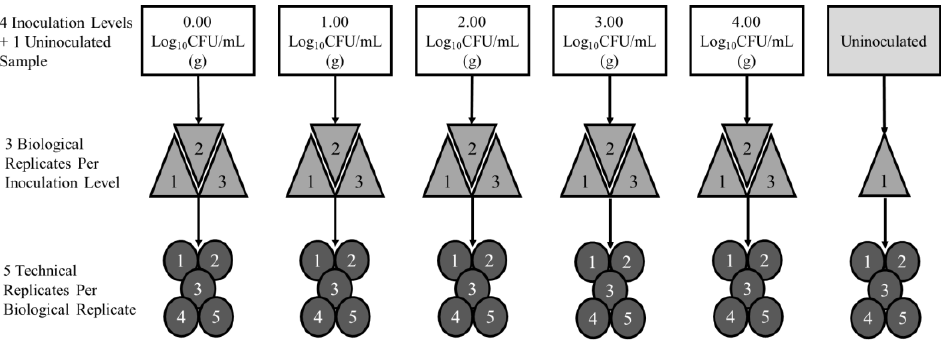
Figure 1. Curve Development Experimental Design for Boot Swabs, Processing Rinsates, Ground Chicken, and Ground Turkey.